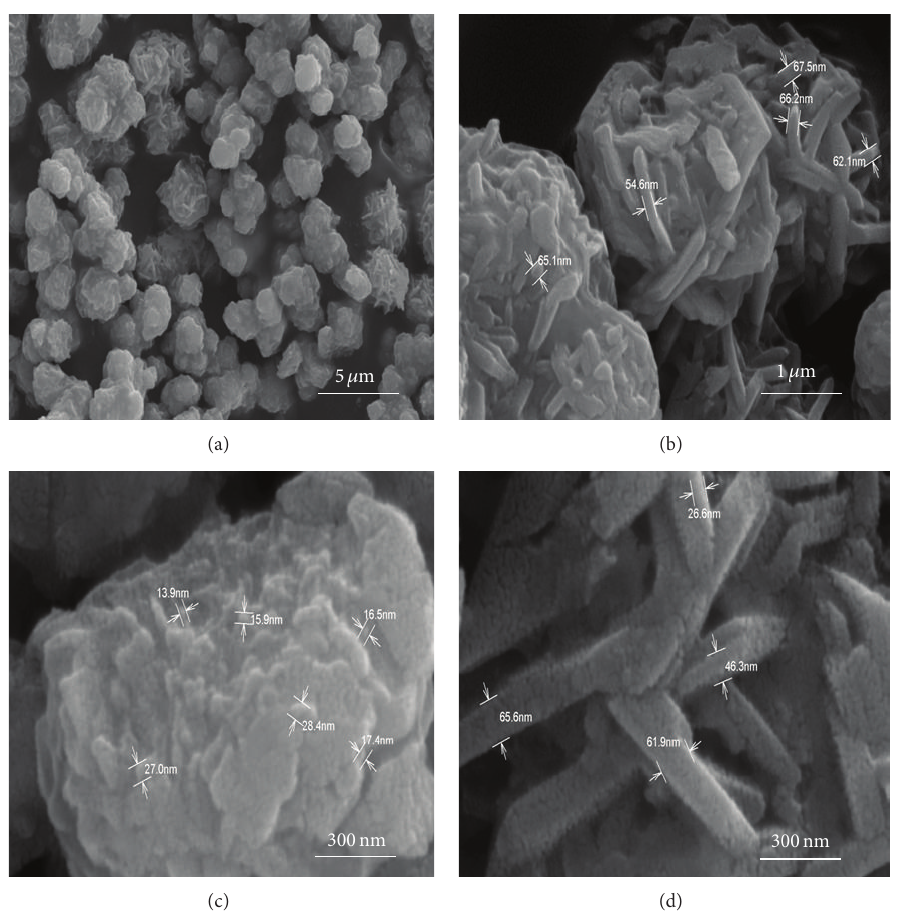
Figure 2: FE-SEM images of CuS nanostructures without CTAB for 5 hrs at 150 ∘ C at different